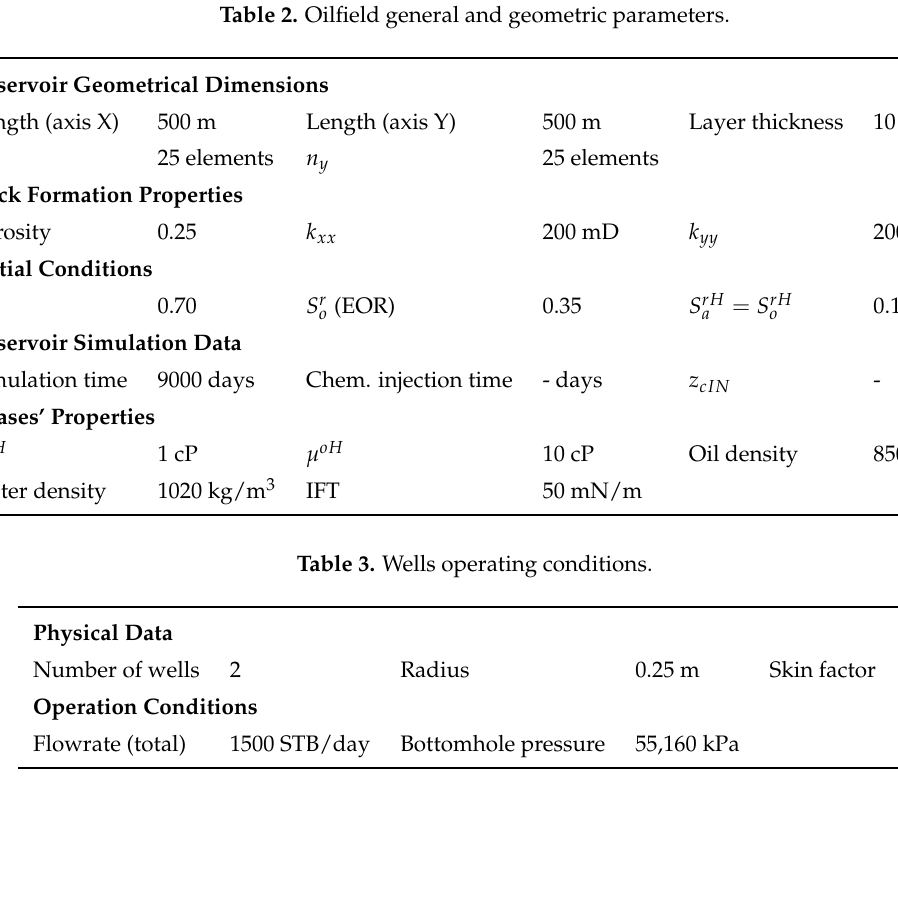
Table 2. Oilfield general and geometric parameters.